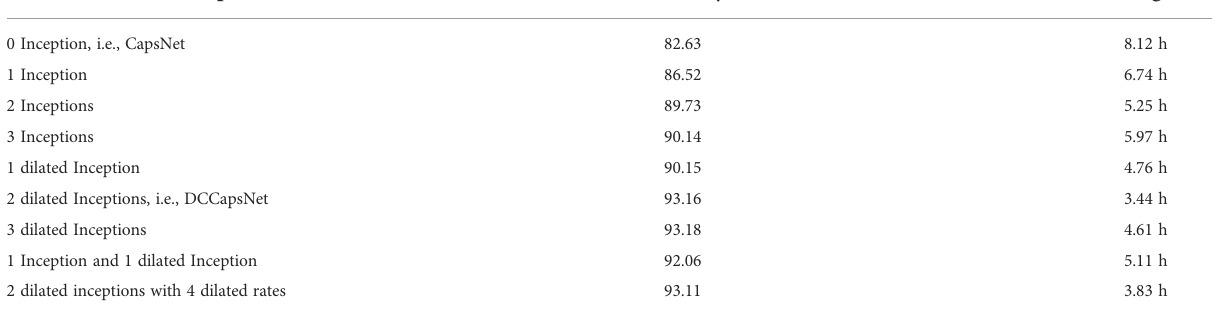
TABLE 4 The results of CapsNet and modi fi ed CapsNet with different Inception modules. Insert module into CapsNet